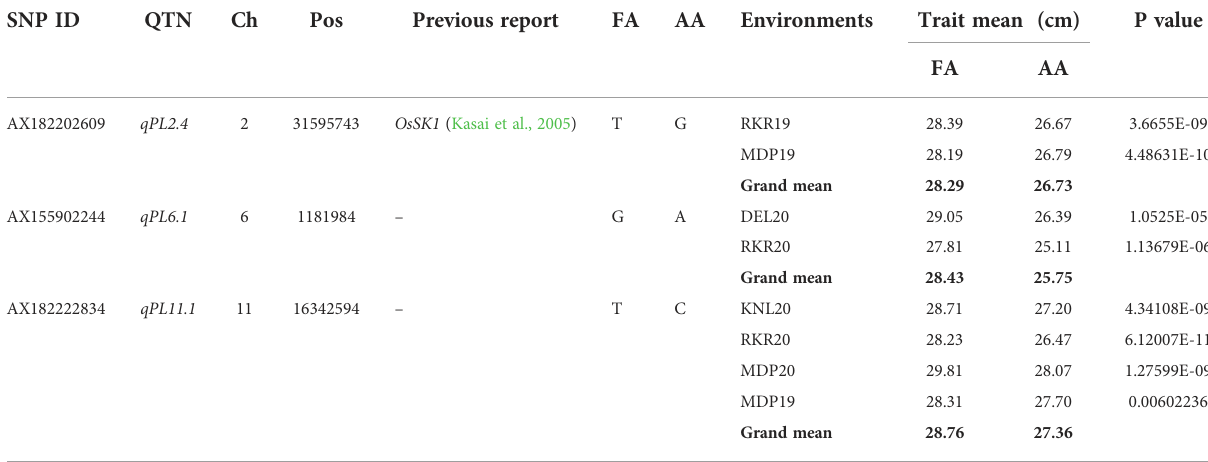
TABLE 9 Allelic effects of selected MTAs identi fi ed in multiple locations for Panicle Length (PL). SNP